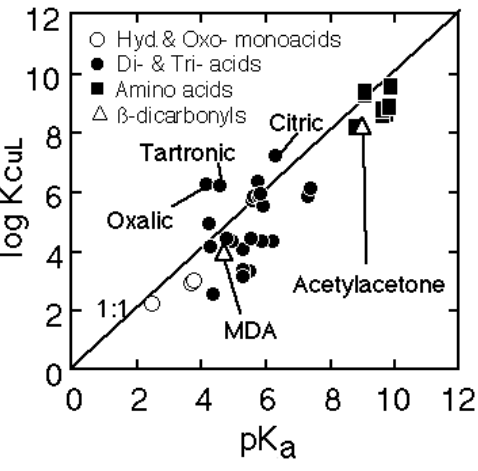
FIGURE 1 . The relationship between pK a and the logarithm of stability constants of some organic ligands for the cupric ion as listed in Table 1 (except for amino acids, which are not listed). constants (about 10 3 M atm –1 for the acids), so very high atmospheric concentrations are required if there is to be substantial complex formation with copper or iron. In the case of acetic acid,